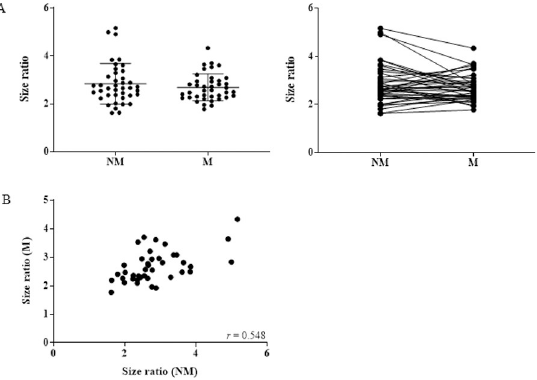
Fig 2. Integrity of cfDNA does not change during menstruation. (A) CfDNA integrity assessed via the ALU-115/ ALU-247 size ratio in 40 healthy women at NM and M phases (p = 0.0931). (B) Scatter plot of size ratio at NM and M phases (r = 0.548; p =